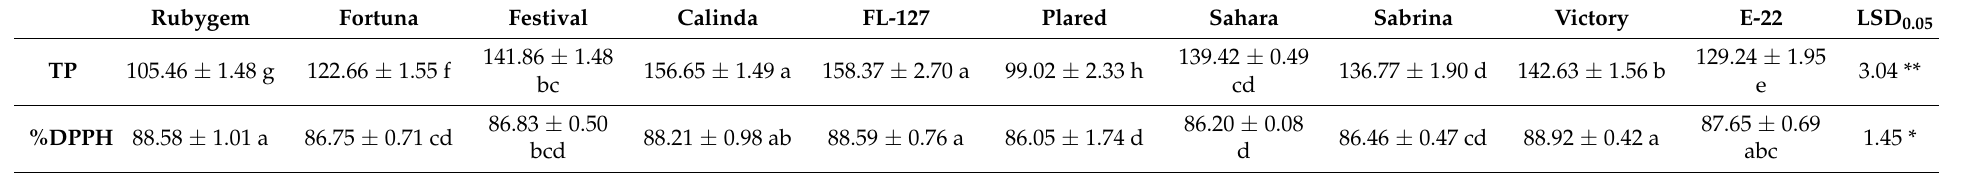
Table 1. Total phenol (mg GAE 100 g − 1 FW) and antioxidant activity (% DPPH inhibition) in fruits of ten strawberry varieties. Rubygem